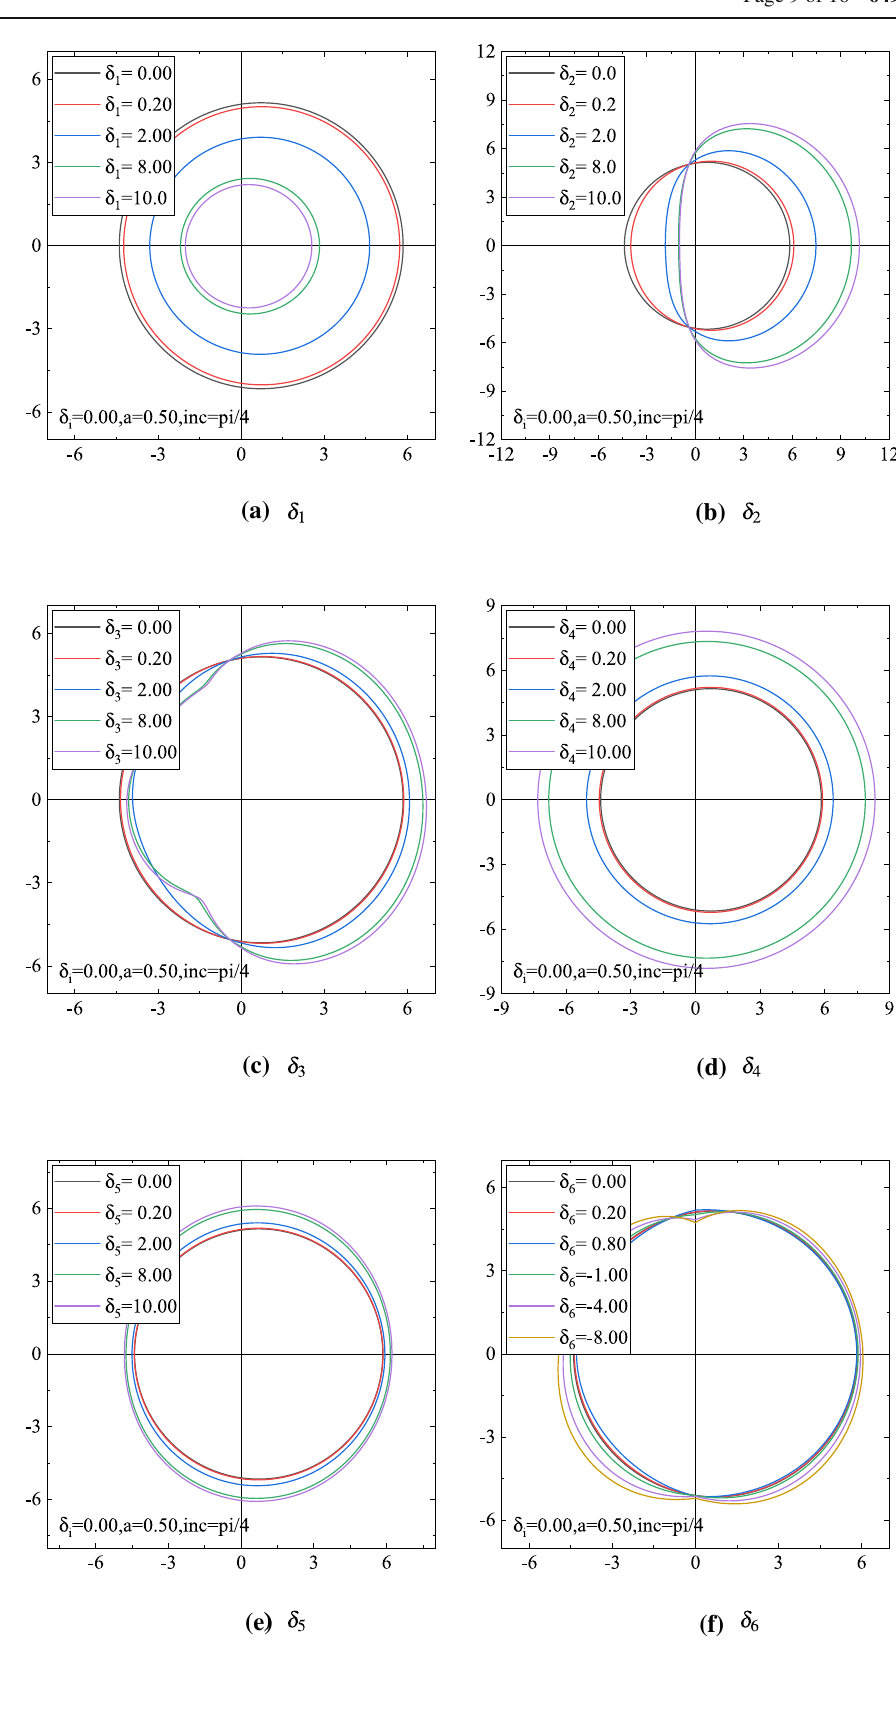
images in the KRZ spacetime. The a – f are for the shadow corresponding different values of δ . And the text δ i = 0 in the graph means that other parameters except one varying in the plot equal to